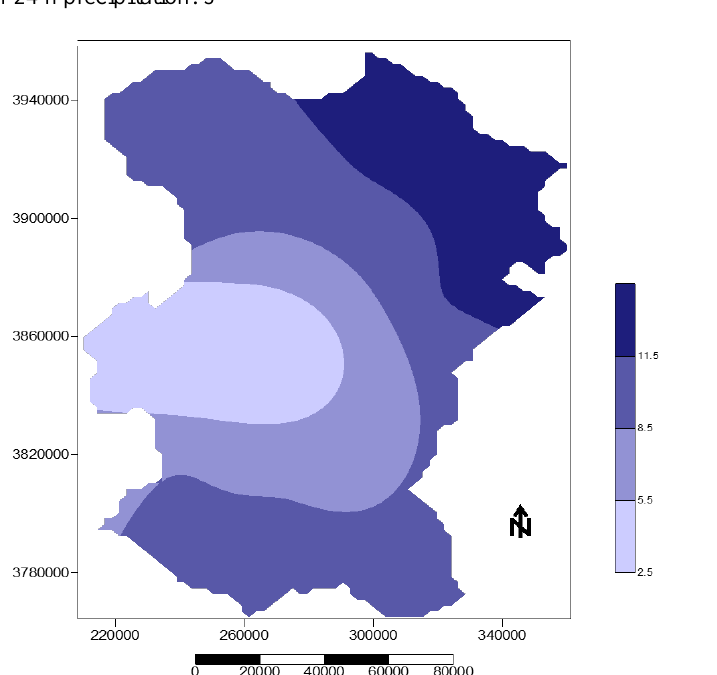
Fig. 2. Zoning mean maximum 24- hour precipitation of Gamasyab and Gharechay